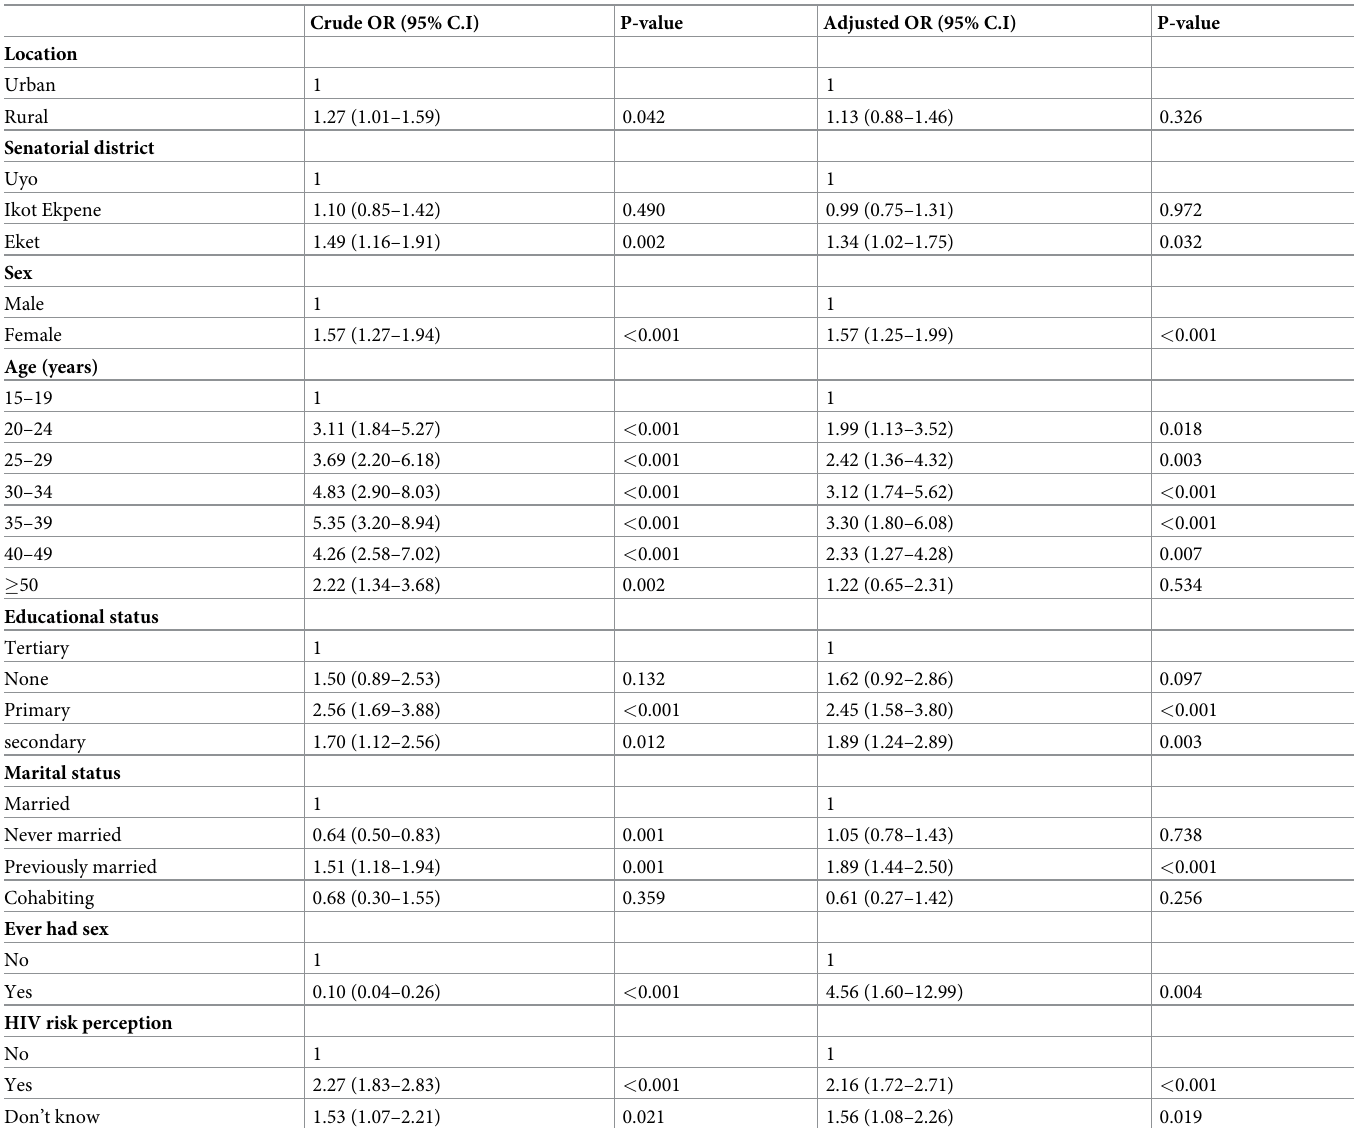
Table 4. Factors associated with HIV